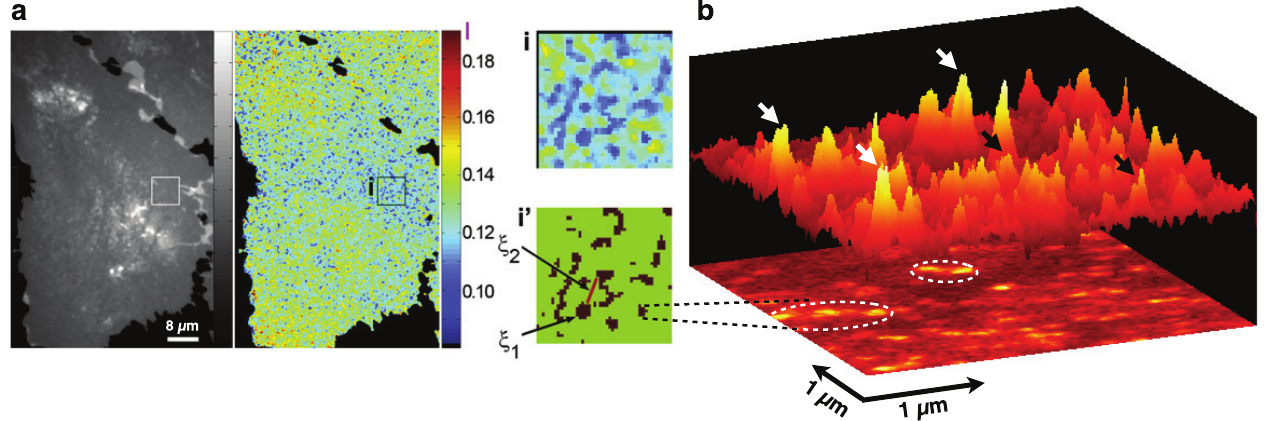
Figure 4. A spatial view of the cell membrane: hierarchical organization of proteins. ( a ) Quantitative analysis of the spatial distribution of glycosyl phosphatidylinositol-anchored proteins (GPI-APs). On flat regions of relatively constant fluorescence intensity (grayscale), the anisotropy images (pseudocolored, where low values indicate increased numbers of clusters) display a hierarchical distribution of GPI-AP (e.g., in the form of nanoclusters and characteristic distances between nanocluster-rich regions). Homo -Förster resonance energy